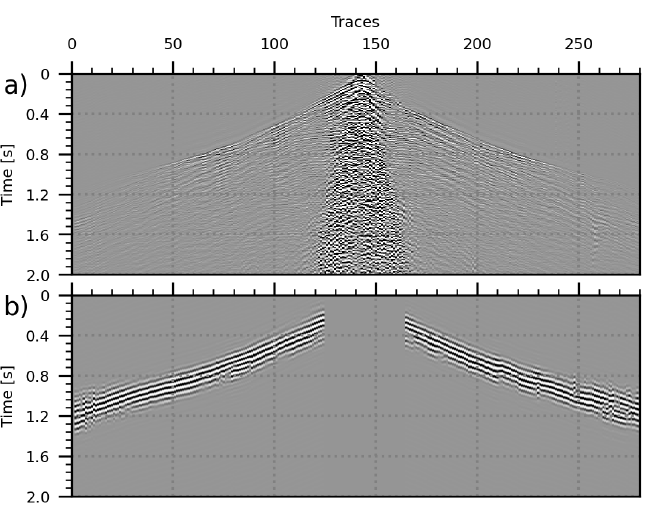
Figure 10. The initial V P model. The red stars and blue triangles indicate the schematic locations of sources and receivers.